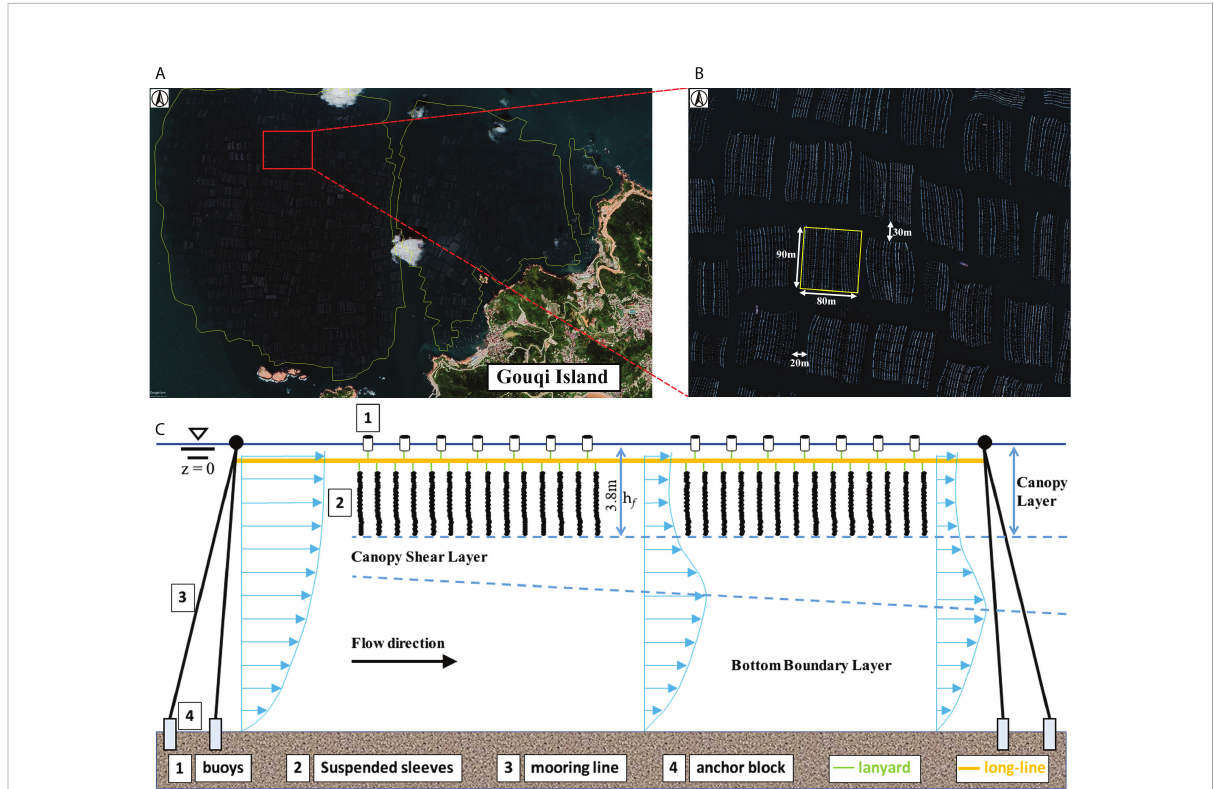
FIGURE 2 (A) Satellite view of farms at the north of Gouqi Island from Google Earth, August 20, 2018. (B) A zoom-in satellite view of a local farming region that shows the con fi guration of mussel farms. A typical aquaculture unit of mussel farms outlined by the yellow line. (C) Side view of the components of aquaculture facilities. Three layer fl ow structures exist around the facility. h f is the farm penetration